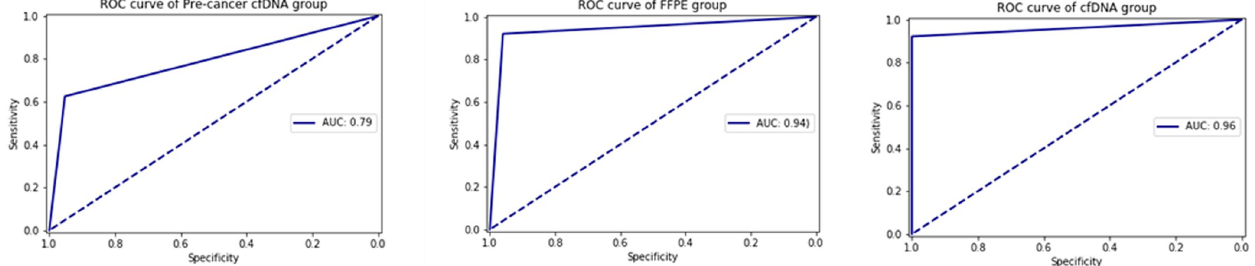
Fig 3. Receiver Operating Characteristic (ROC) curve and area under the curve (AUC) to evaluate the performance of the assay. a, precancerous lesions cfDNA samples analysis. b, CRC FFPE samples analysis; c, CRC cfDNA sample analysis.